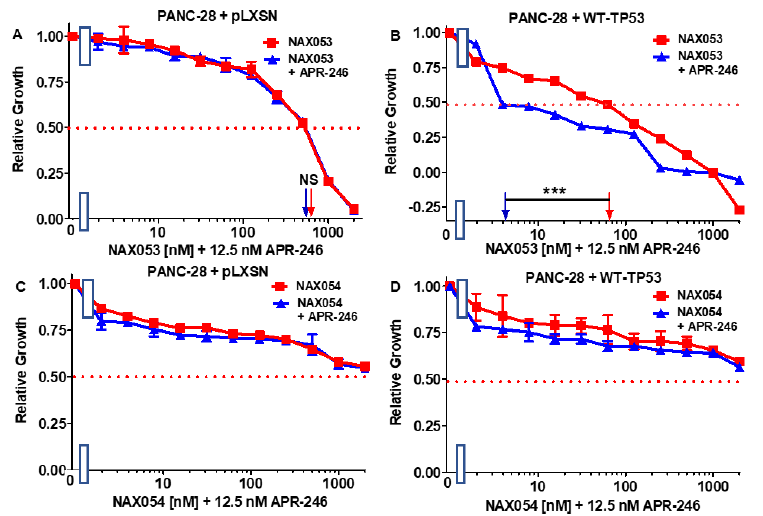
Figure 14. APR-246 enhances the effects of NAX053 when WT-TP53 is precent in PANC-28 cells but not in the absence of WT-TP53, while APR-246 does not increase the effects of NAX054 in the